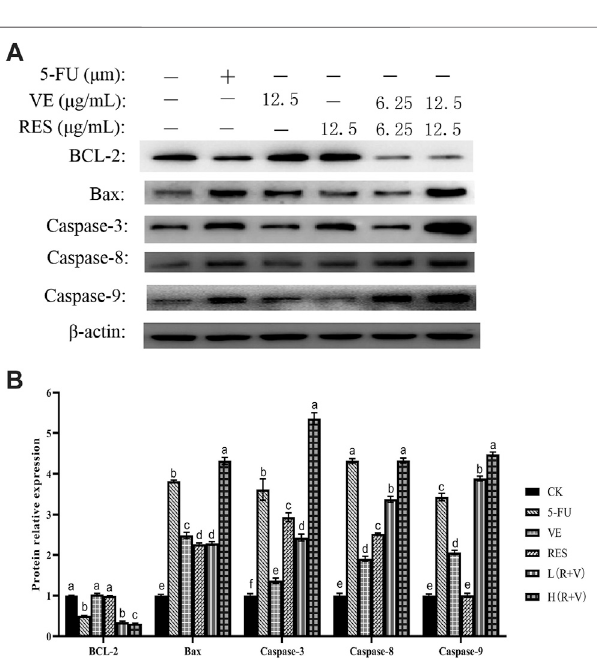
The above results indicate that the combined effect of RES and VE can signi fi cantly downregulate the expression of anti-apoptotic proteins ( p < 0.05) and signi fi cantly